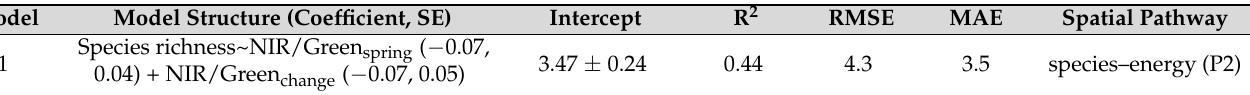
Figure 6. The importance of predictor variables for the explanation of plant species richness in the species–energy model, the most supported spatial pathway (P2). Table 1. Results of the multi − model selection approach with the three different spatial pathways evaluated to monitor plant species richness in the grassland parcels of Peneda − Gerês, Portugal ( n = 24). Model selection was performed using generalized linear models with a Poisson distribution of errors and the Akaike information criteria corrected for small sample sizes (AICc) to identify and rank the pathways. Pathways with Δ AICc ≤ 2.0 were considered models receiving strong support. a